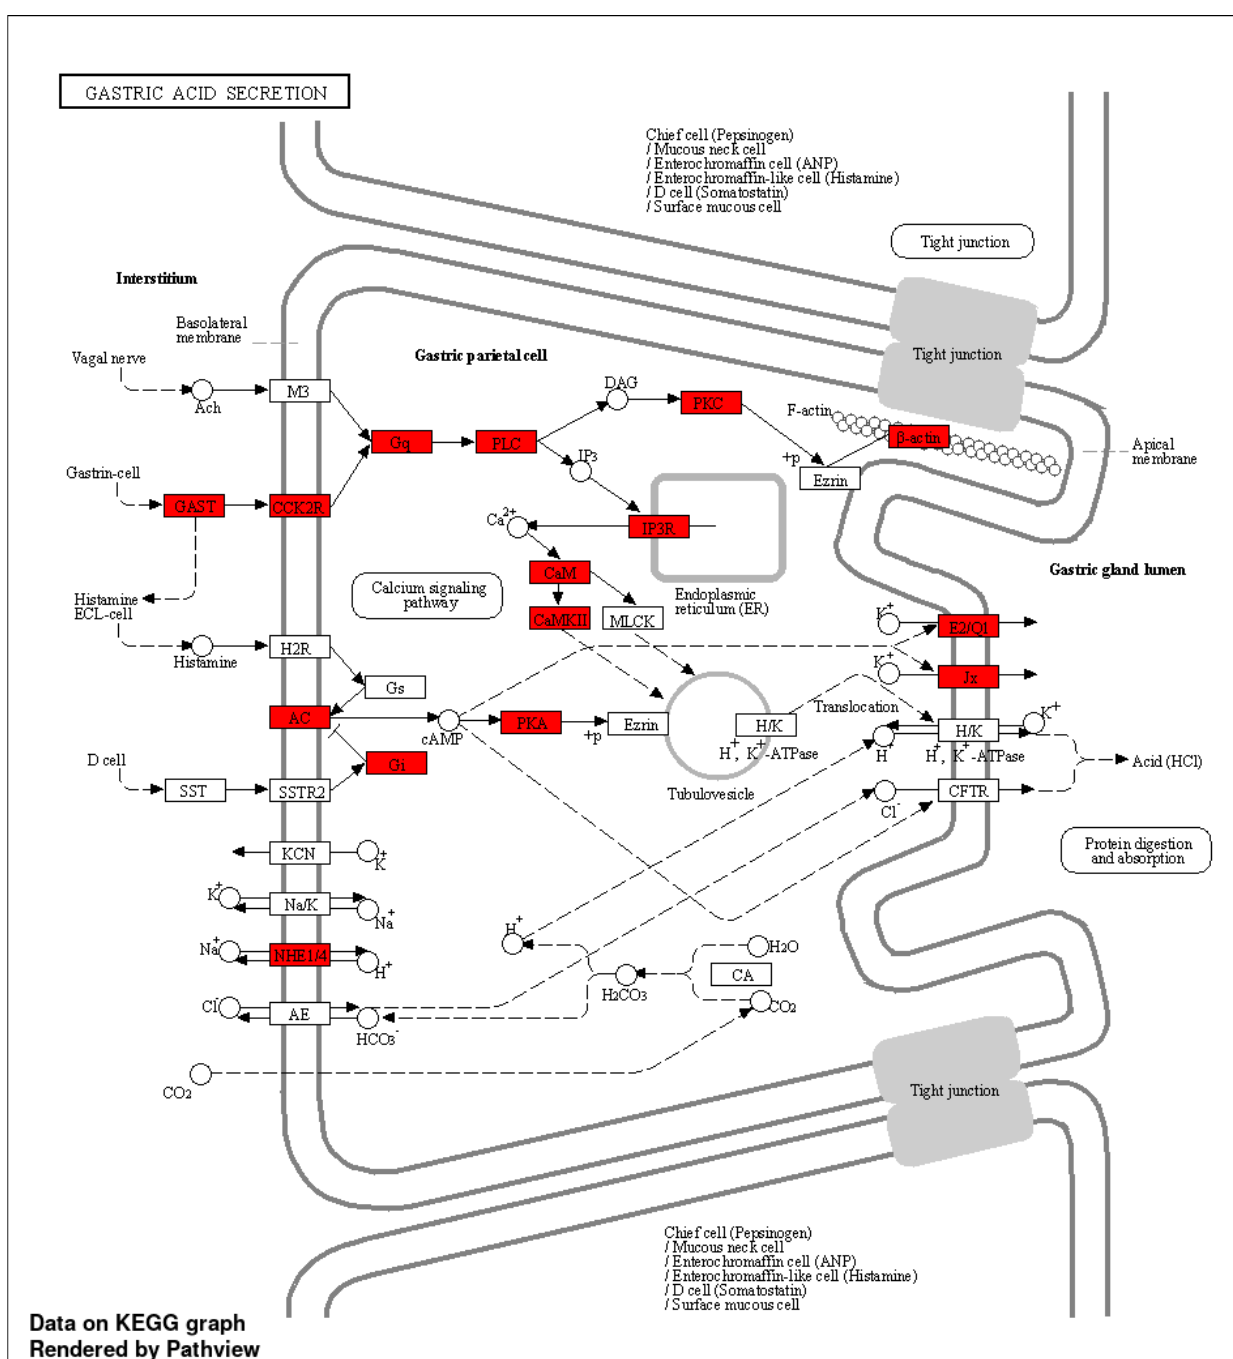
Figure 4. KEGG gastric acid secretion pathway obtained from the induced differentially CTCF-binding sites (DCBS). Genes from the induced DCBS are highlighted in red.